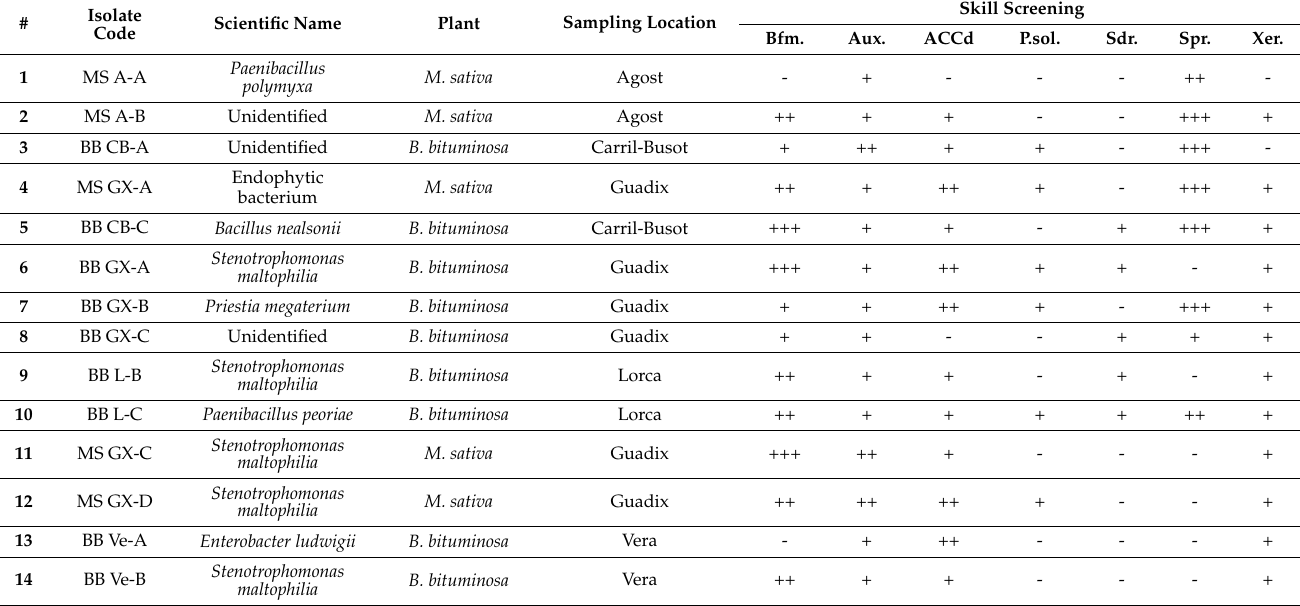
Table 3. Strains isolated from M. sativa and B. bituminosa seeds. List of strains isolated and